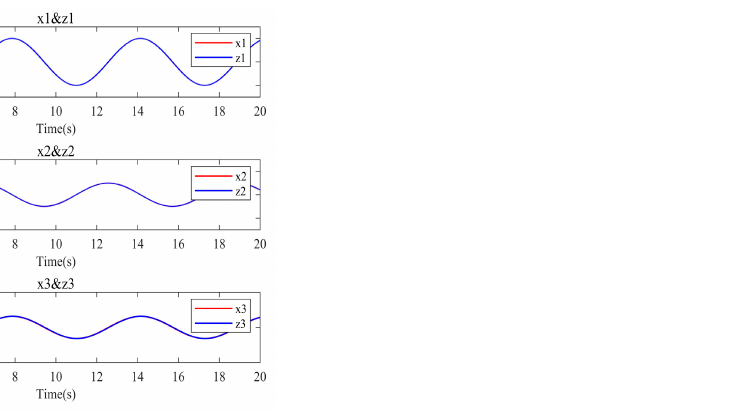
19 of 22 Figure 14. Learning curve of IT2FNN for observer bandwidth